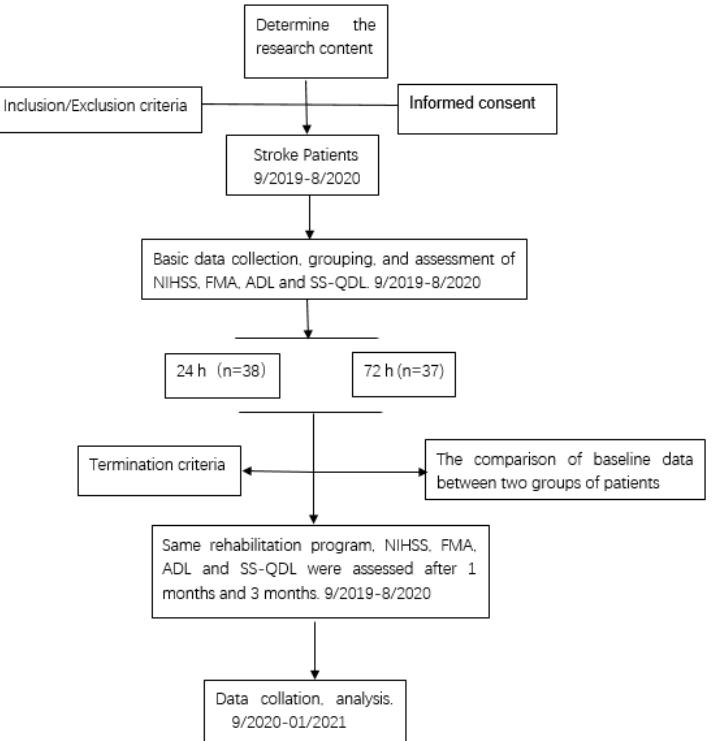
Figure 5. Study flow chart. The time course of this study, inclusion, exclusion, termination criteria, and study groupings are displayed graphically.